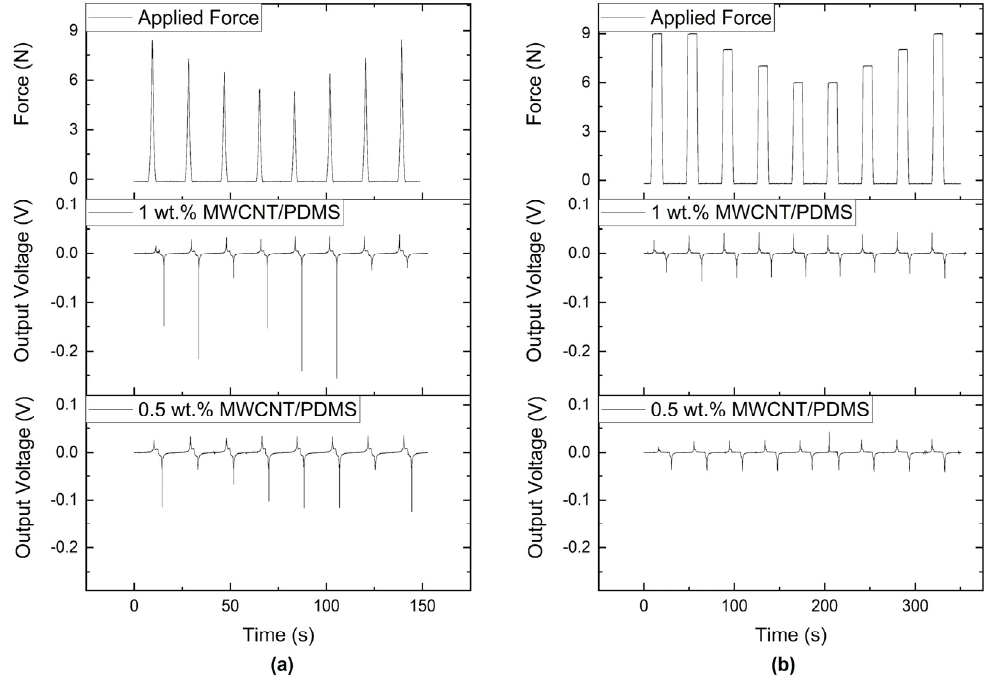
Figure 15. Triboelectric effect obtained for the nanocomposites prepared with the parallel line magnetic pattern with 0.5 and 1 wt.% of MWCNT; ( a ) unloading-loading peaks, ( b ) unloading-loading delayed peaks. The top images represent the applied force by the testing machine.